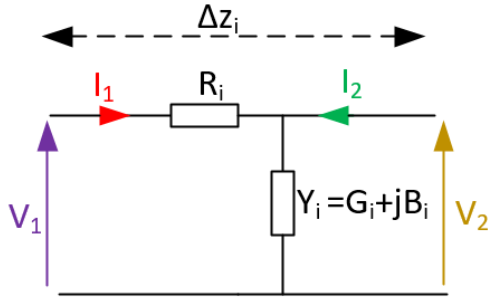
Figure 2: The transmission line model for the i th body